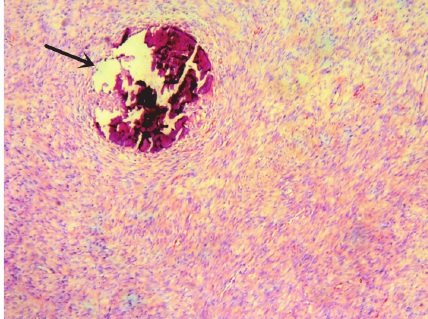
Figure 3: The HE stain of the lesion displayed spindle-shaped tumor cells arranged in bundles with scattered psammomatous calcifications (black arrow). H&E ×